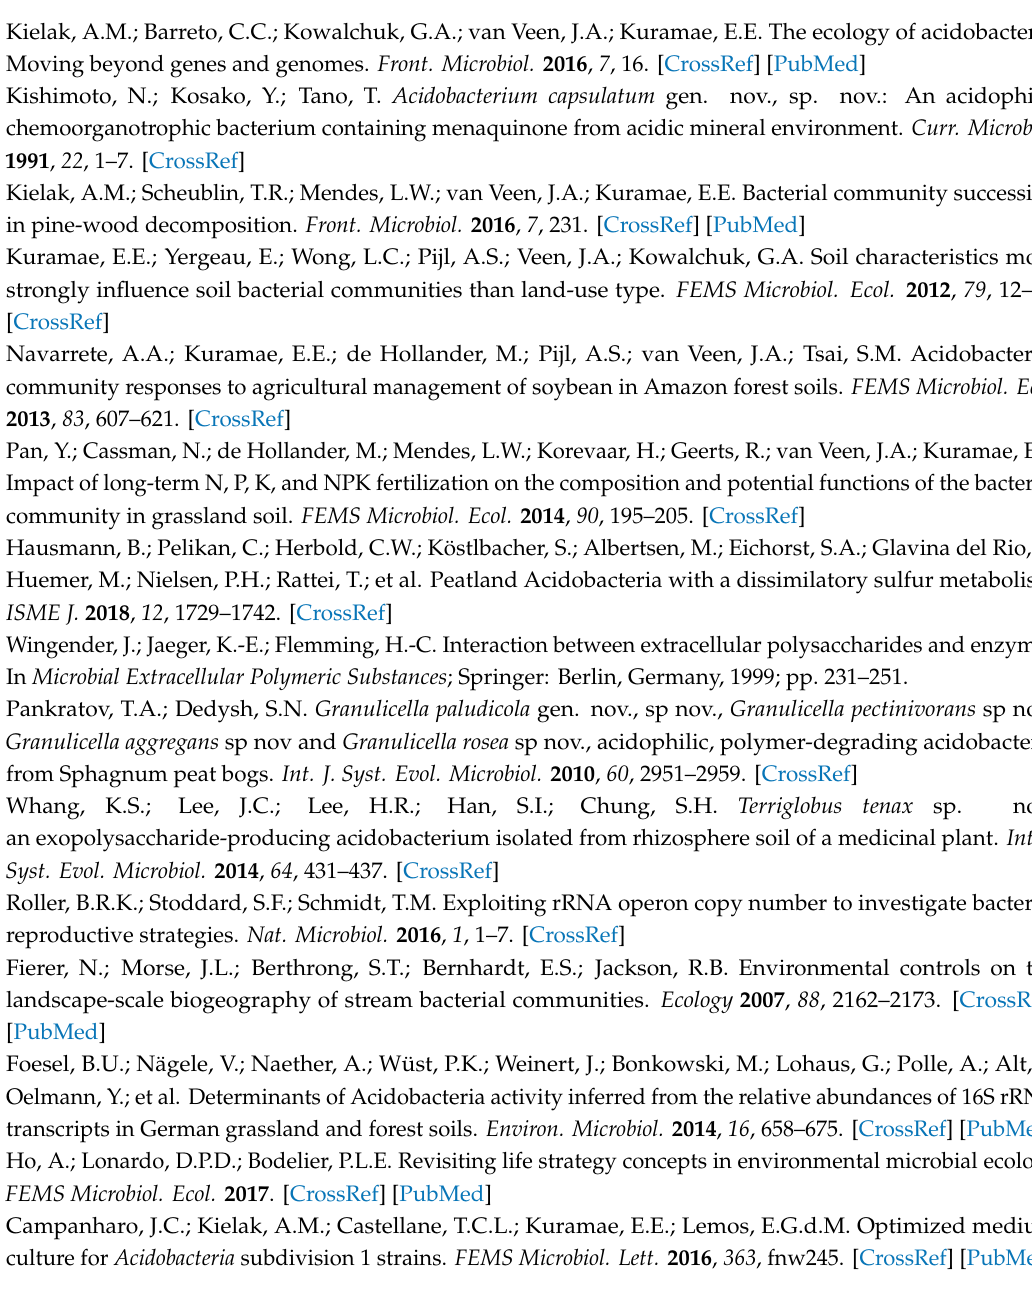
sugar treatment, Table S5: Number of proteins assigned to KEGG metabolic pathways, Table S6: Di ff erentially downregulated proteins in high sugar